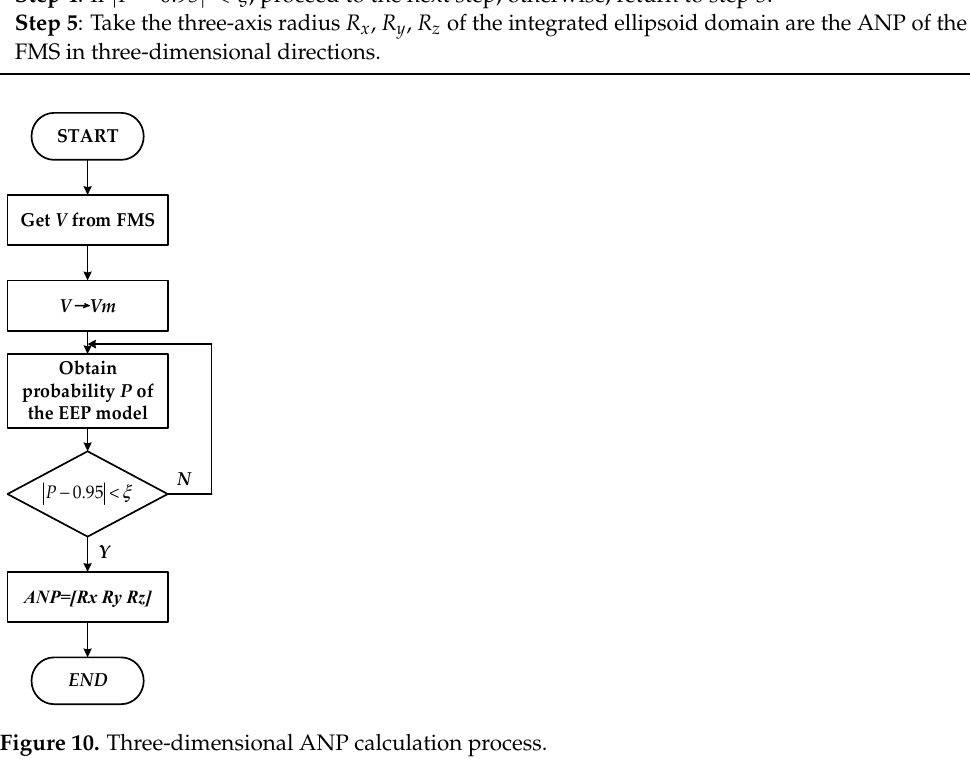
Figure 9. Comparison between EEP model and SEP model in YOZ plane.